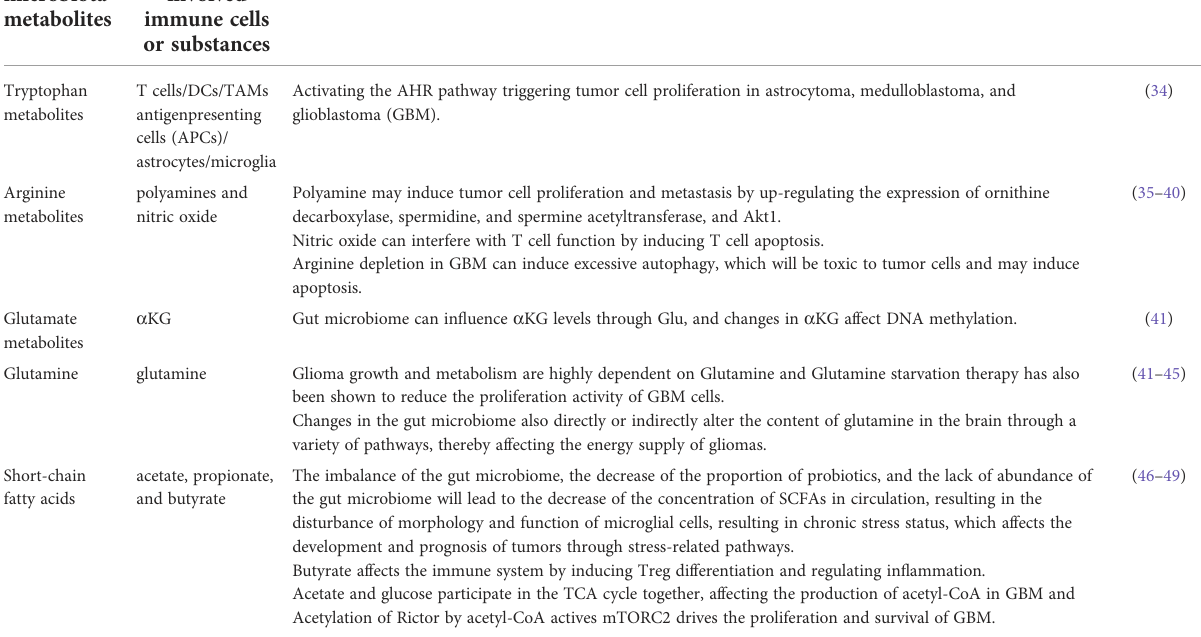
TABLE 2 Effects of gut microbiota-metabolites on